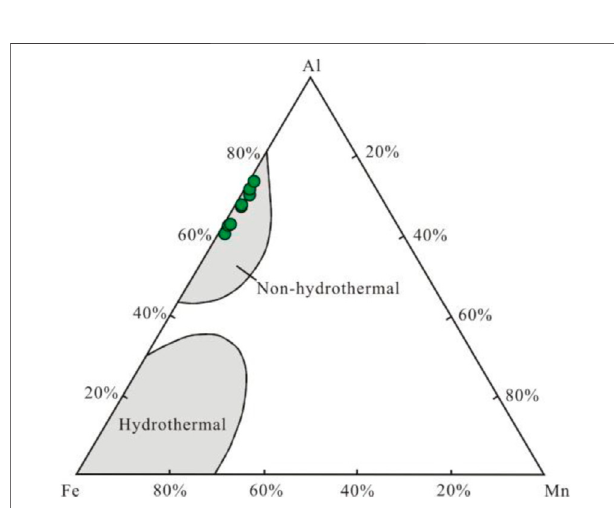
FIGURE 6 | Diagrams of the siliceous hydrothermal origins of the shale samples.